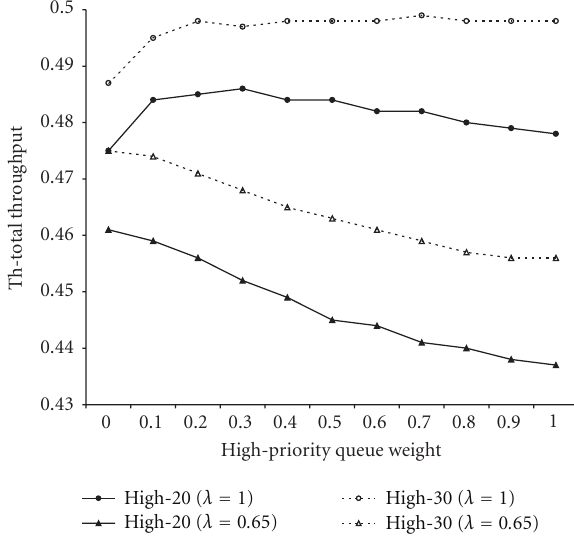
Figure 5: MIN throughput under varying high-priority queue